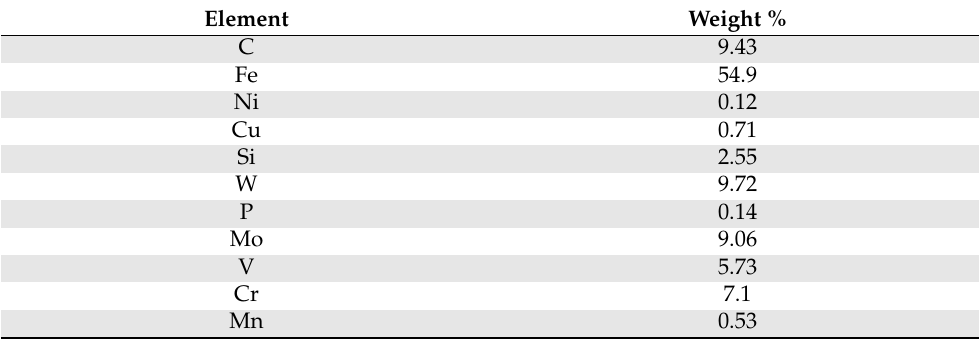
Table 2. Composition of steel substrate analyzed by EDX